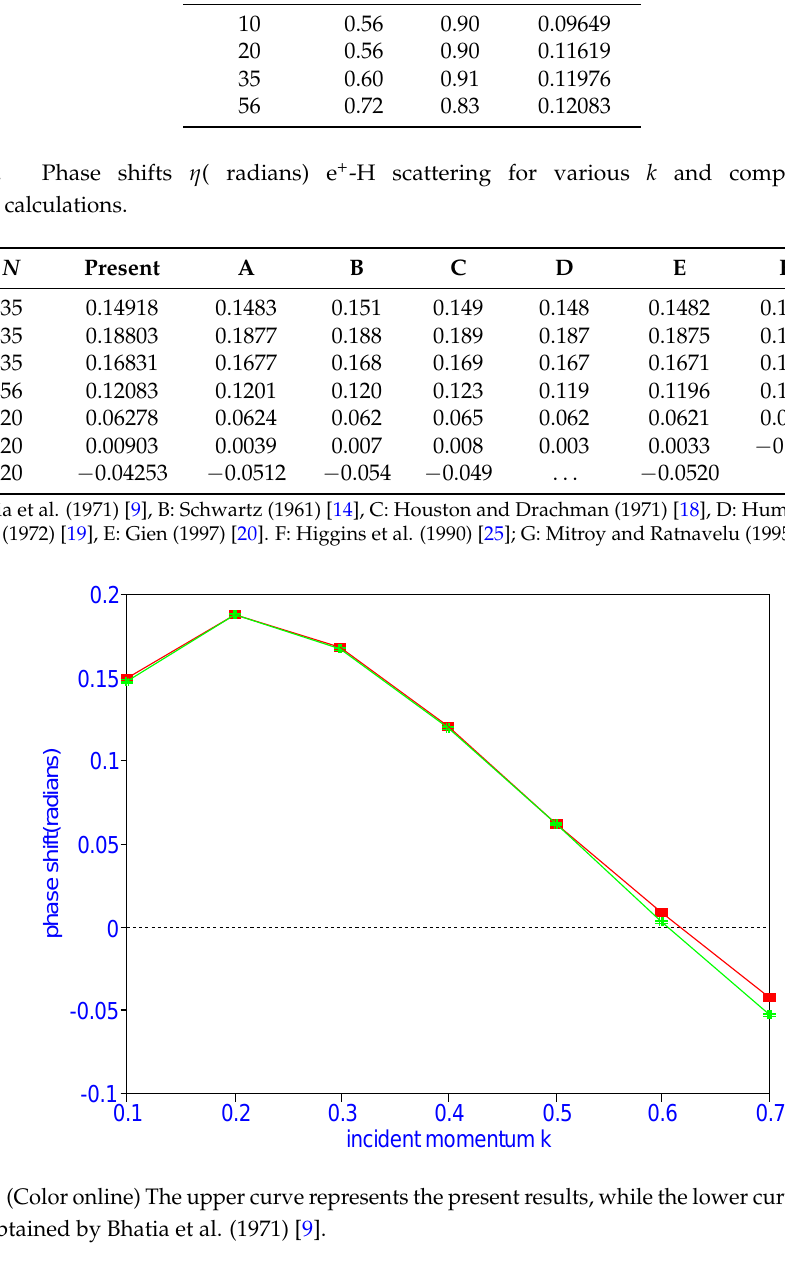
(41) Table 3. Convergence of the scattering length for e + ‐ H scattering with respect to the number of correlation terms N .